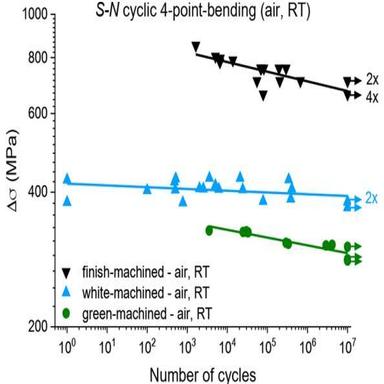
S-N curves from cyclic fatigue tests carried out in 4PB on bend bars with finish-machined, white-machined and green-machined surface finish. (For interpretation of the references to colour in the Figure, the reader is referred to the web version of this article).